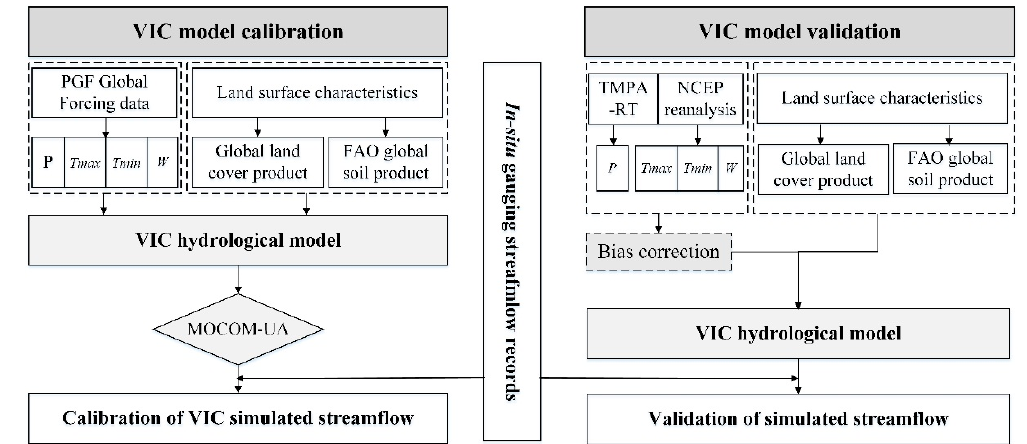
Figure 3. Flowchart of VIC model calibration and validation.